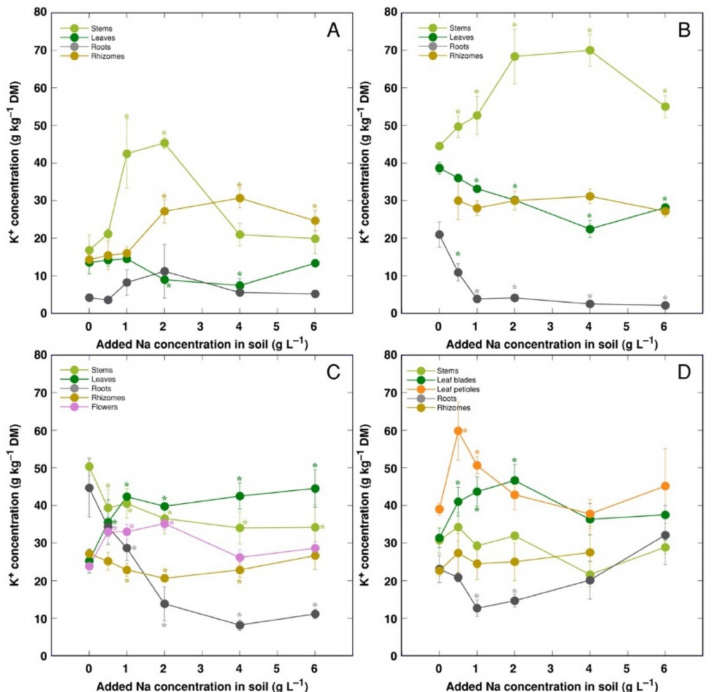
Figure 6. Changes in K + concentration under the effect of increasing soil salinity in different parts of Calystegia sepium accessions CSe1 ( A ), CSe2 ( B ), CSe3 ( C ) and Calystegia soldanella ( D ). Na + was added in a form of NaCl. Data are means from three replicates for each concentration ± SE. Asterisks of the respective color indicate statistically significant differences ( p < 0.05) from control.